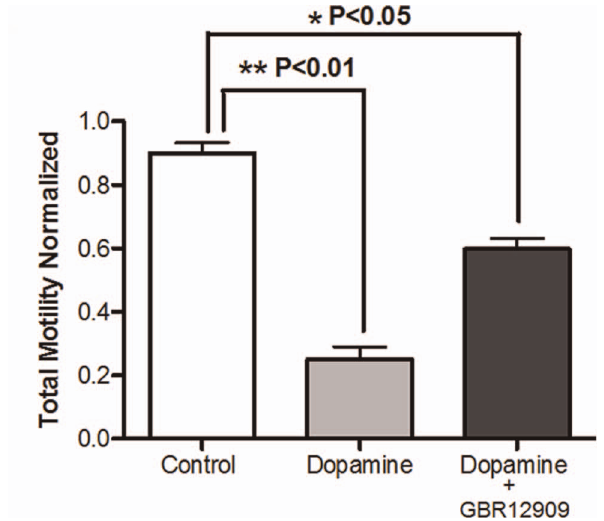
Figure 4. Dopamine transporter inactivation attenuates the inhibitory effect of 1 mM dopamine on total sperm motility. Equine sperm were incubated at 37 u C with 1 mM dopamine, with and without the specific DAT inhibitor, 10 m M GBR12909 for 1 hour, in Withenn’s buffer. Total motility was calculated using the CASA system, with a minimum of 500 sperm analyzed per experiment. Total motility was normalized to time zero of the control. Results are the mean 6 SEM of four independent experiments. The different letters show significant changes between each treatment with p , 0.01. We have considered in each experiment a control to normalize the results to the basal sperm condition before the incubation with dopamine and its respective vehicle.